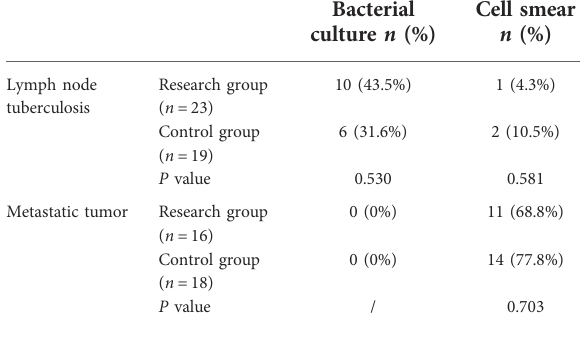
TABLE 3 Comparison of diagnostic effects of puncture cytology and microbiology.